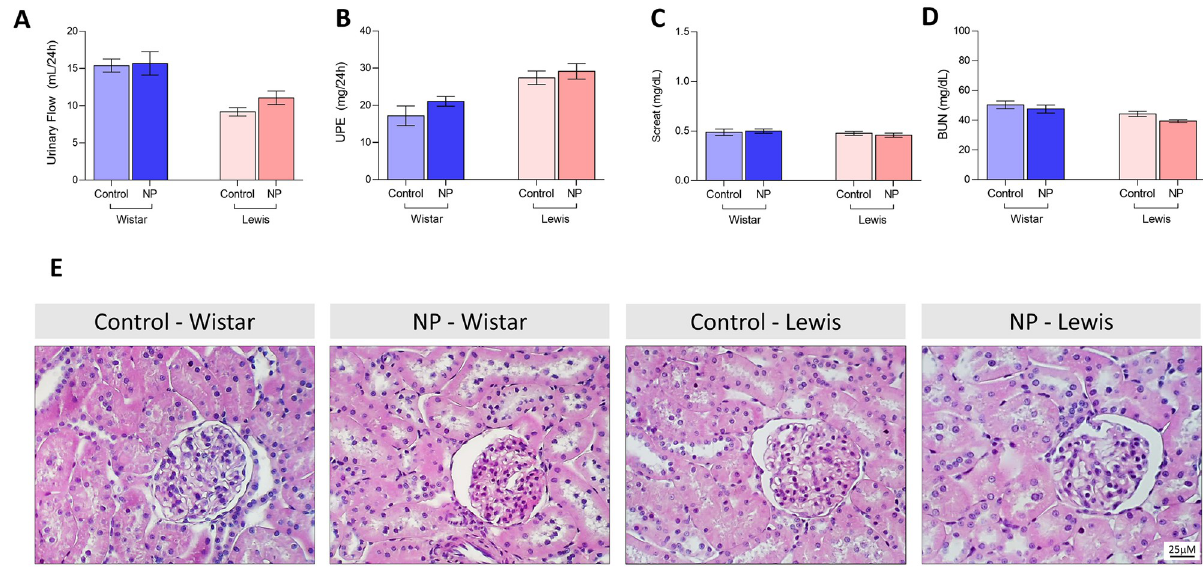
Fig 2. Renal Function: A) Urinary flow (mL/24h) B) Proteinuria (mg/24h), C) BUN (mg/dL), D) Screat (mg/dL). E) Illustrative microphotographs of HE-stained kidney sections under final 400x magnification.